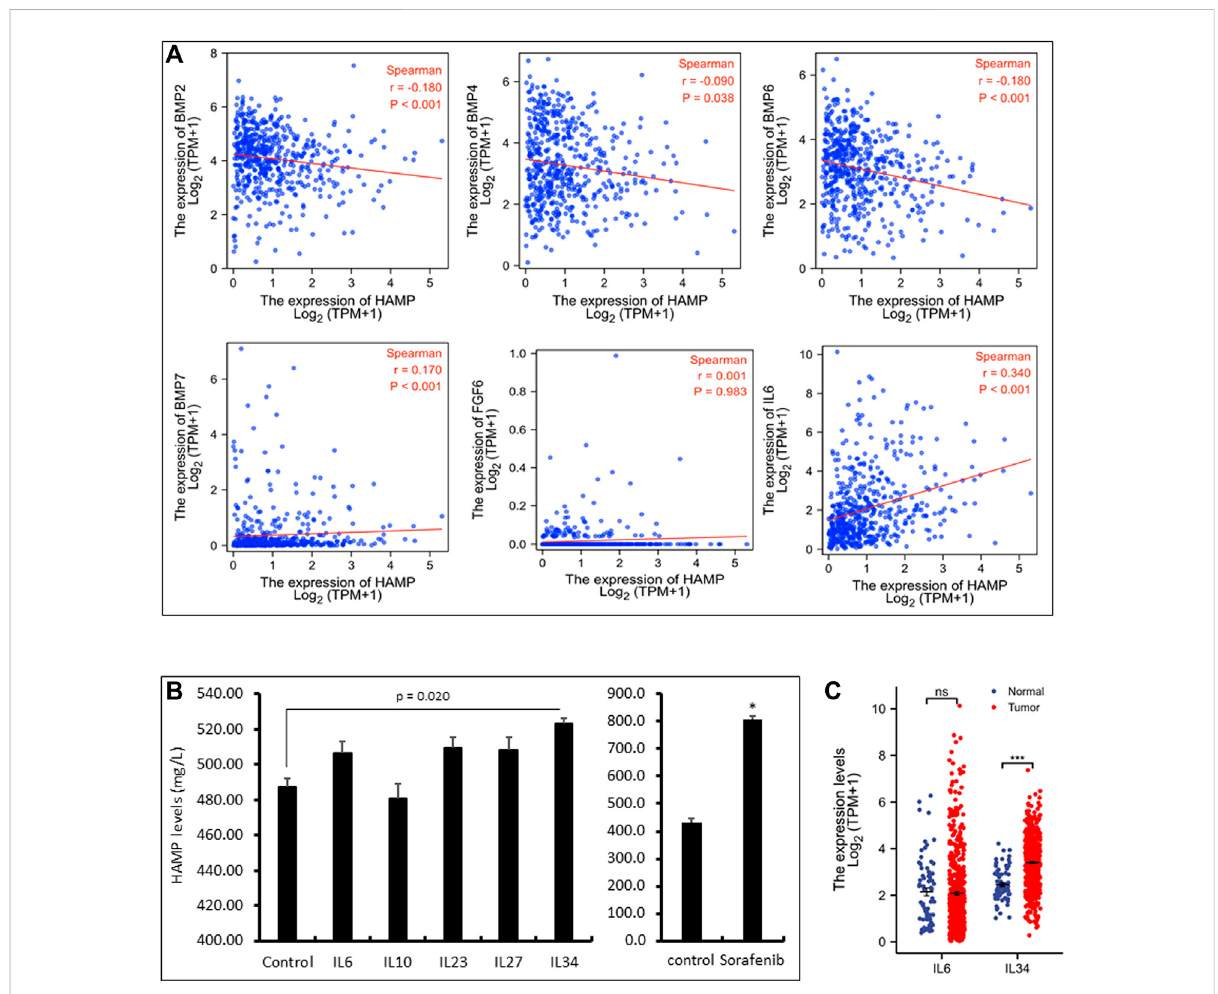
FIGURE 3 HAMP expression is positively correlated with IL6 and IL34 levels. (A) Spearman correlation analysis between HAMP and selective cytokines in ccRCC tissues was conducted using the TCGA-KIRC RNA-seq dataset (539 cases). (B) Caki-1 cells were treated with each cytokine (100 ng/ml) and Sorafenib (10 μ M) for 24 h as indicated. Cell culture media were harvested for ELISA assay. The error bar represents the standard error of the MEAN (SEM). The asterisk indicates a signi fi cant difference from the control treatment (Student t -test, p < 0.05). (C) Comparison of IL6 or IL34 expression in ccRCC tissues compared to normal kidney tissues using the TCGA-KIRC RNA-seq dataset. Ns, no signi fi cance. *** p < 0.001 (paired t -test and Wilcoxon rank-sum